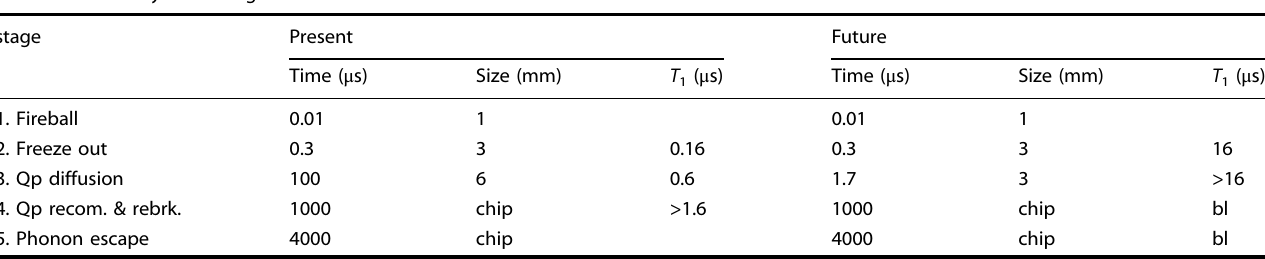
Fig. 8 Design of quasiparticle traps. Illustration of quasiparticle traps for a Xmon (left) and differential (right) transmon, where additional islands in the wiring and ground planes are made from a lower-gap superconductor. These islands can be directly connected to the wiring or through a thin tunnel barrier. Table 5. Summary of heating